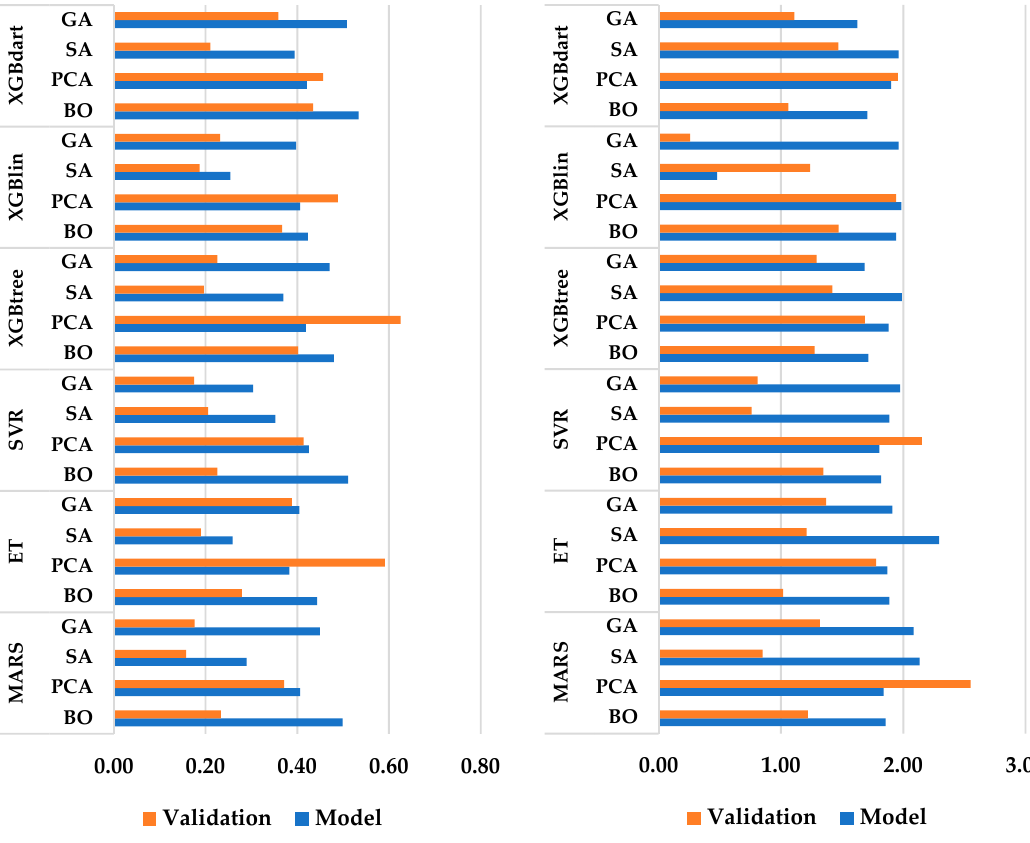
Figure 9. Machine learning model performance of R 2 ( left ) and RMSE ( right ) using input dataset from selected combinations of lidar and hyperspectral data.